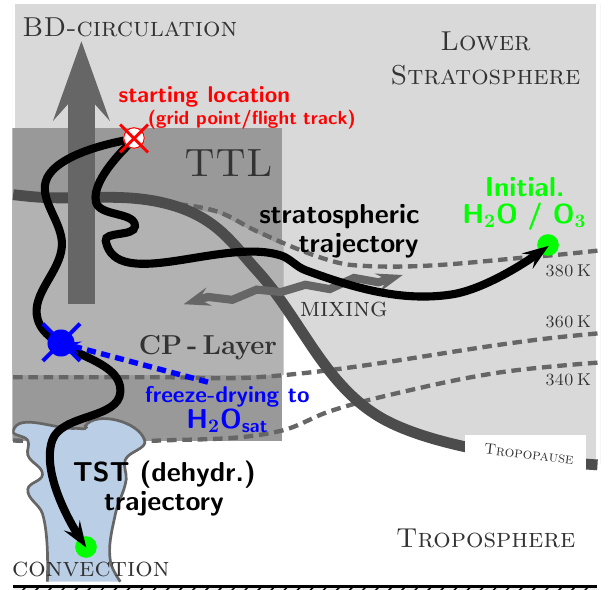
Fig. 1. Schematic of the method used in this paper (see text). The figure shows troposphere-to-stratosphere transport (TST trajecto- ries) and purely stratospheric trajectories. The upwelling branch of the stratospheric Brewer-Dobson (BD) circulation is displayed as a thick grey arrow, quasi-horizontal stratosphere-troposphere ex- change as a grey wavy arrow, particular isentropes as thin grey dashed, the tropopause as a grey solid line. The Cold Point (CP) layer between 360 and 380K is coloured light-grey. The black ar- rows characterising typical TST and stratospheric backtrajectories point backwards in time. The red dot shows the starting location. Green dots illustrate the initialisation (locations) of backtrajectories with ECMWF (HALOE) water vapour and ozone at the end points. The blue dot illustrates the location where dehydration to the lo- cal minimum saturation water vapour mixing ratio (H 2 O sat ) occurs along the TST